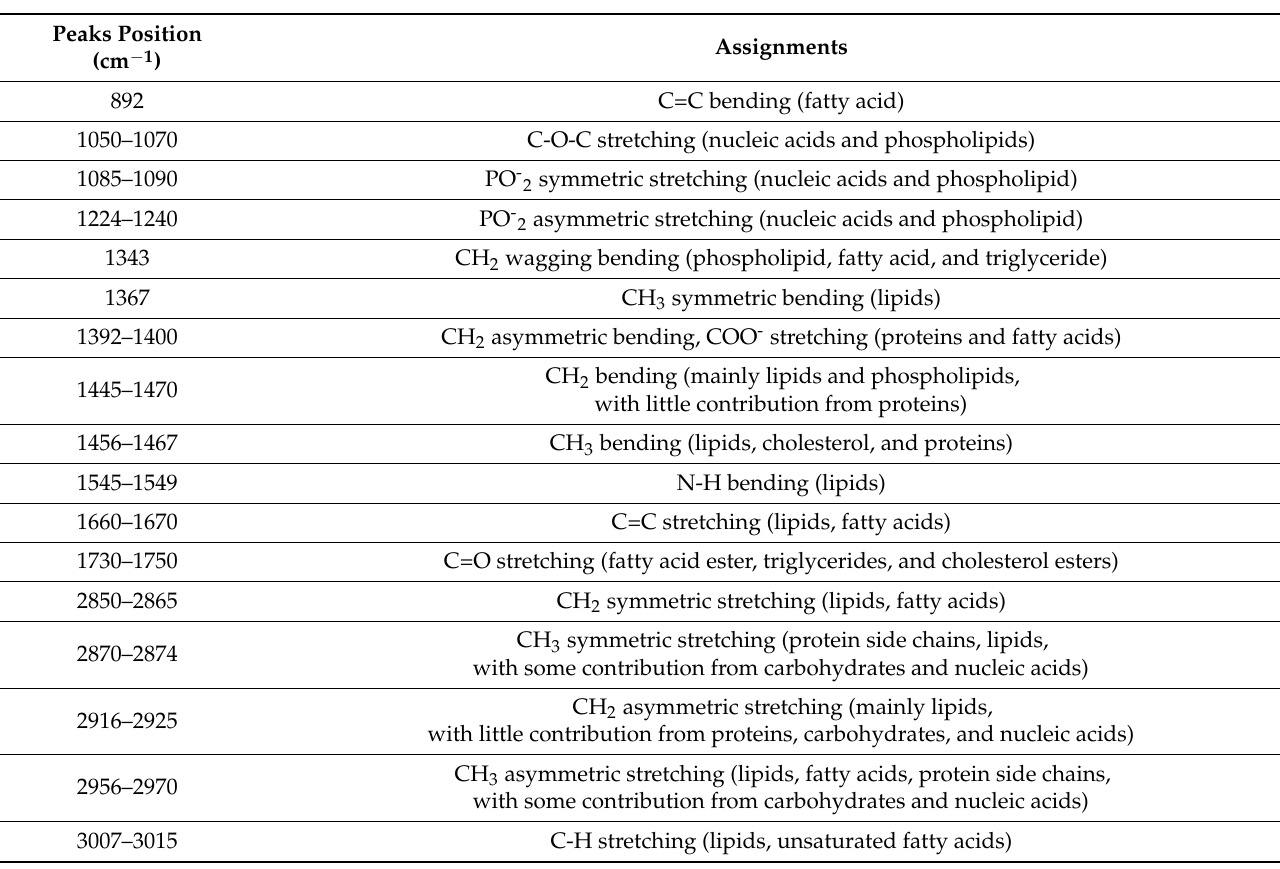
Table 3. Main peaks in FT-IR lipid spectra and their assignments according to [79,93,94]. Peaks